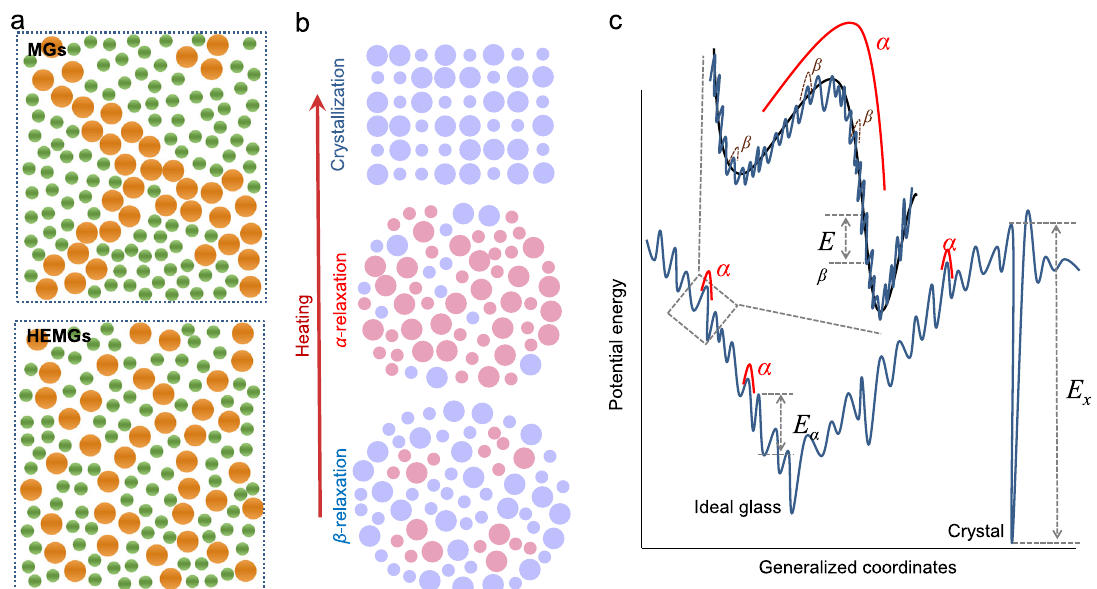
Fig. 6 Schematic illustration of structure and energy landscape of MGs. a Microstructure illustration of HEMGs and traditional MGs. Based on the EDS results, HEMGs present relatively homogeneous elemental distributions which might originate from the high mixing entropy. b Correlation between the evolution of STZs and relaxation behaviors with increasing temperature. The MGs fi nally yield crystallization state at T x . c Schematic potential energy landscape for MGs, β -relaxation relates a reversible hopping event in an inherent megabasin, while α -relaxation corresponds to an irreversible hopping event across different landscape